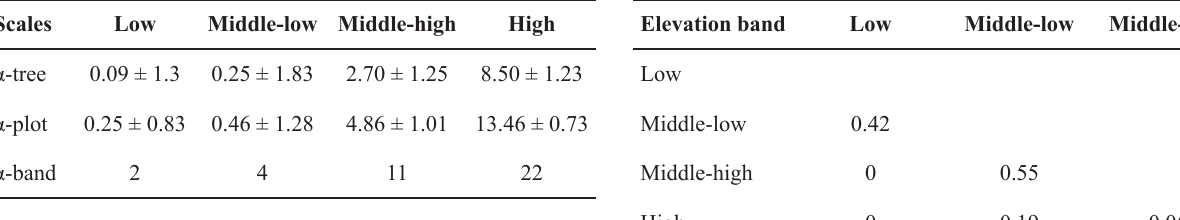
Table 1 – Mean values of alpha diversity for the three sampling scales in each elevational band. The value for band is the total number of species recorded and hence has no standard error.